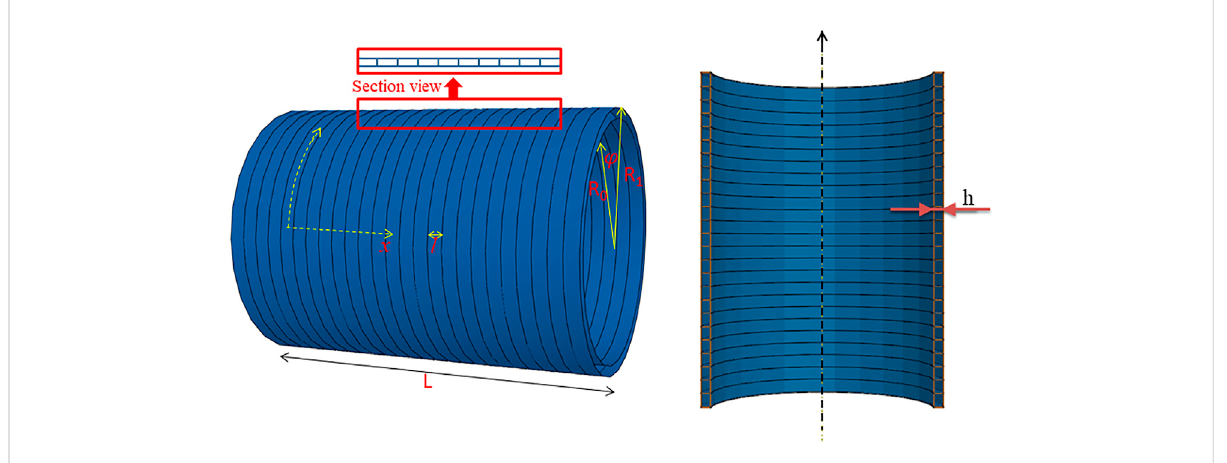
Figure 2 Schematic of ring-stiffened sandwich cylindrical shells.